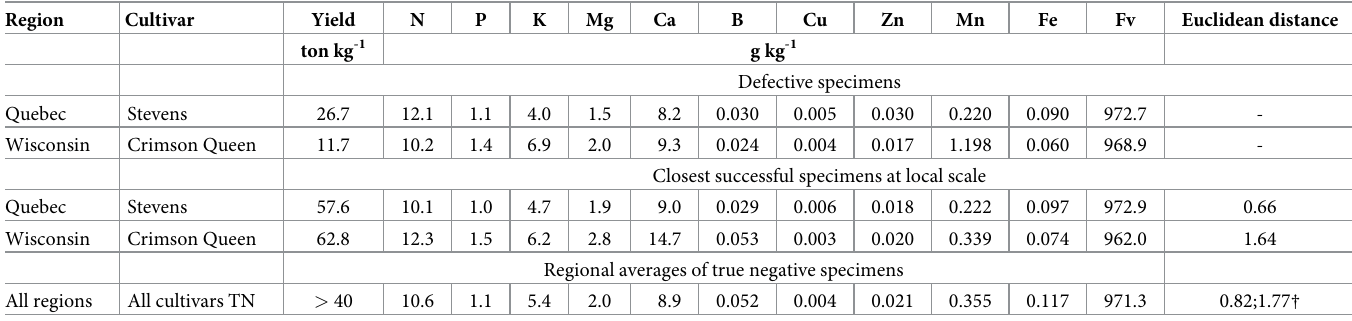
Table 5. Diagnosis of two Quebec and Wisconsin cranberry cultivars against their respective closest Euclidean distances from successful cultivar-specific neighbors. Region Cultivar